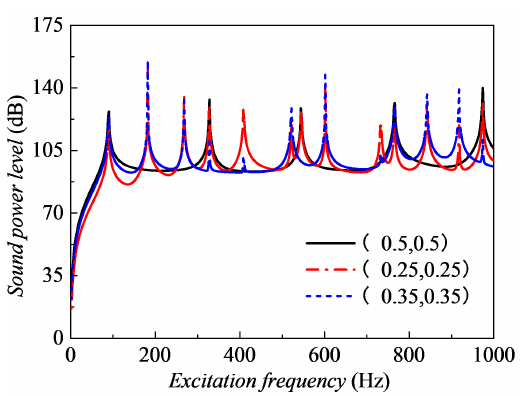
Figure 16: Sound power level of plate with different location of point